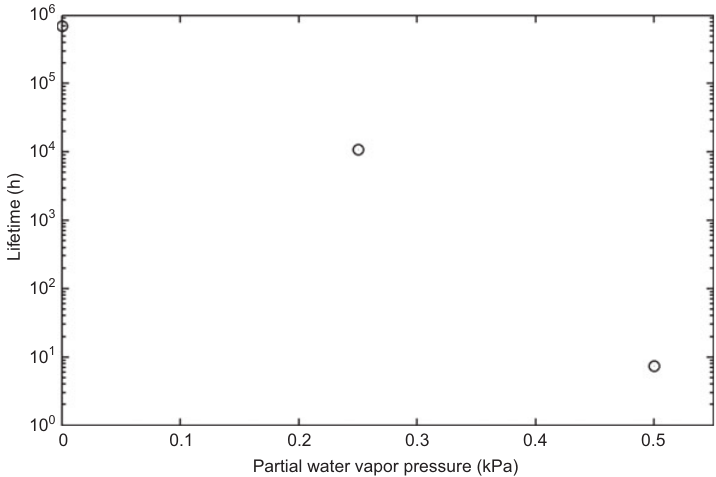
Figure 5 Evolution of the lifetime with the water vapor partial pressure (at 500 ° C and 200 MPa).